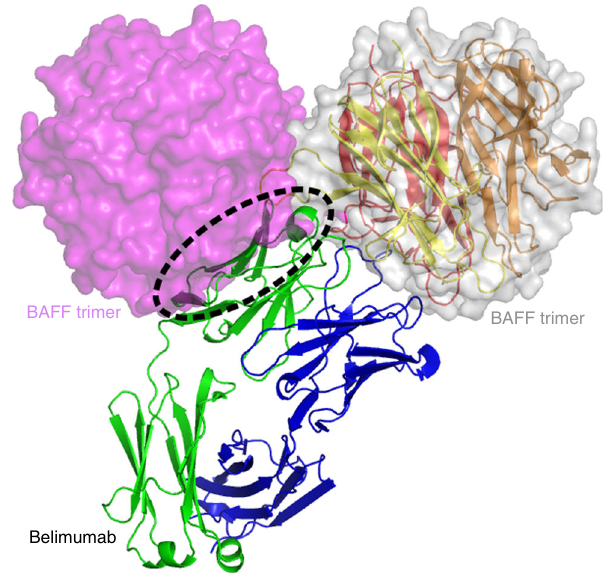
Fig. 5 Blockade of the BAFF trimer – trimer interaction by belimumab. Partially transparent surface model of two neighboring BAFF trimers (purple and white) and a ribbon representation of one BAFF trimer (red, orange, and yellow for each protomer) in complex with belimumab Fab (heavy chain: blue; light chain: green). The dotted ellipse indicates a steric collision between the adjacent BAFF trimer and the bound belimumab